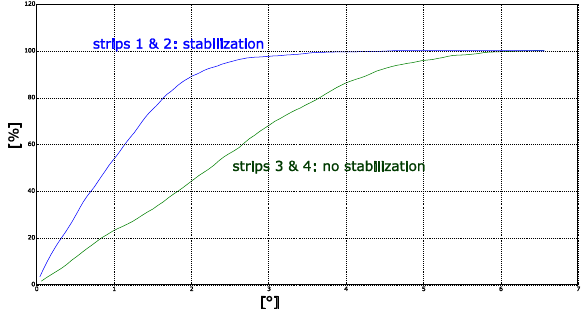
Figure 9. Empirical cumulative distribution function for roll values. Flight #1.